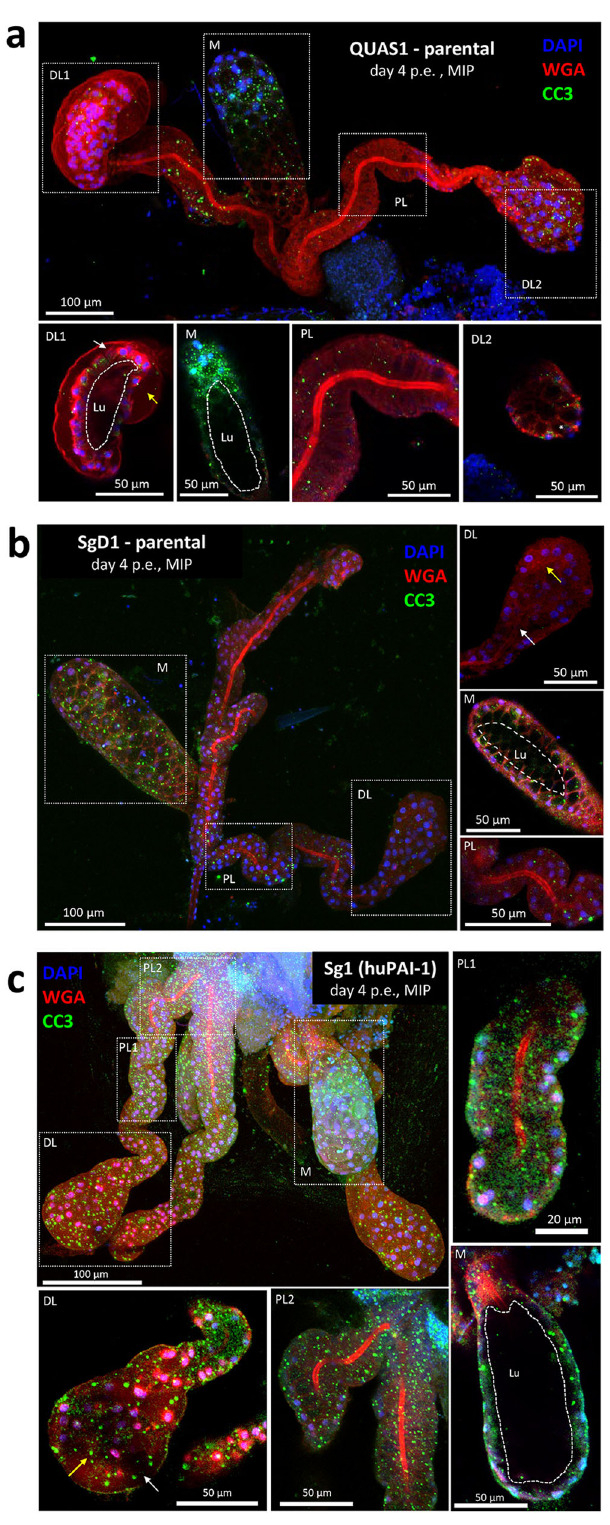
effector and driver plasmids. One parental line with stable expression of the fl uorescence marker was generated for the midgut QF2-driver named MdgD1, and two parental lines were generated for the salivary gland drivers named SgD1 and SgD2 and for the QUAS-effectors named QUAS1 and QUAS2. Genome integration sites were determined for each parental line by splinkerette PCR 34 and sequencing (Supplementary Fig. 2a, b).